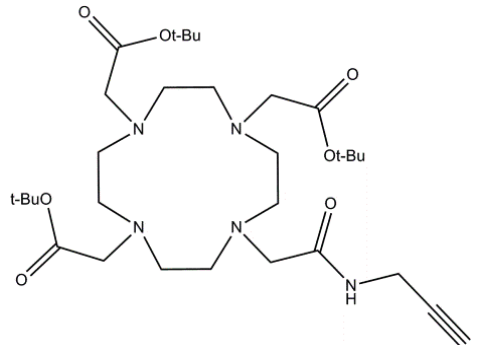
Figure 9. Chemical structure of Product 5 .